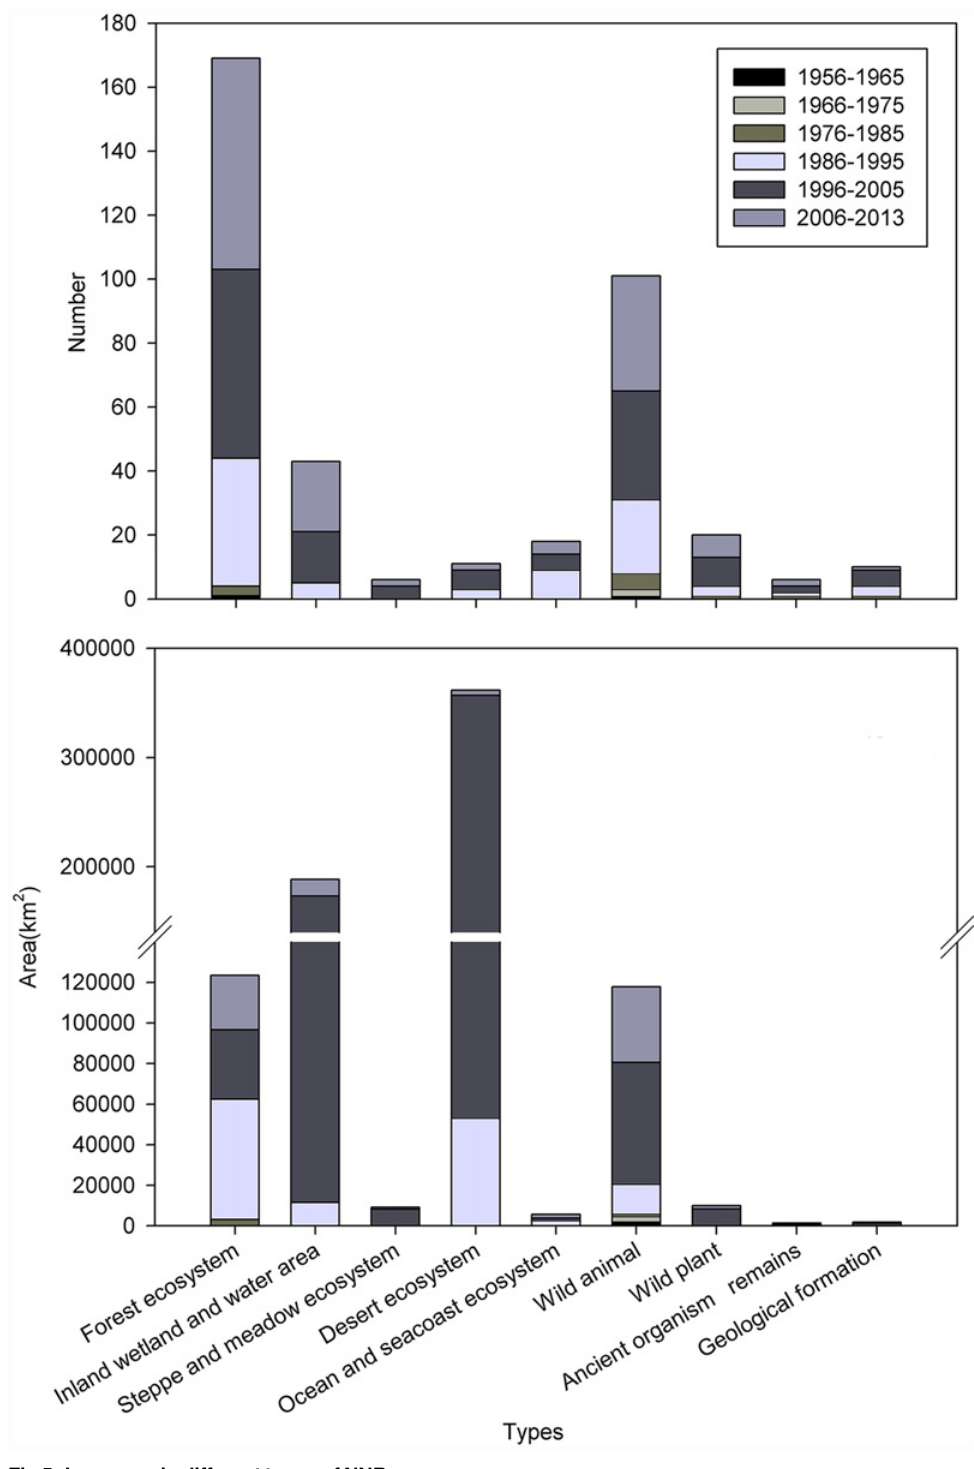
Fig 5. Increases in different types of